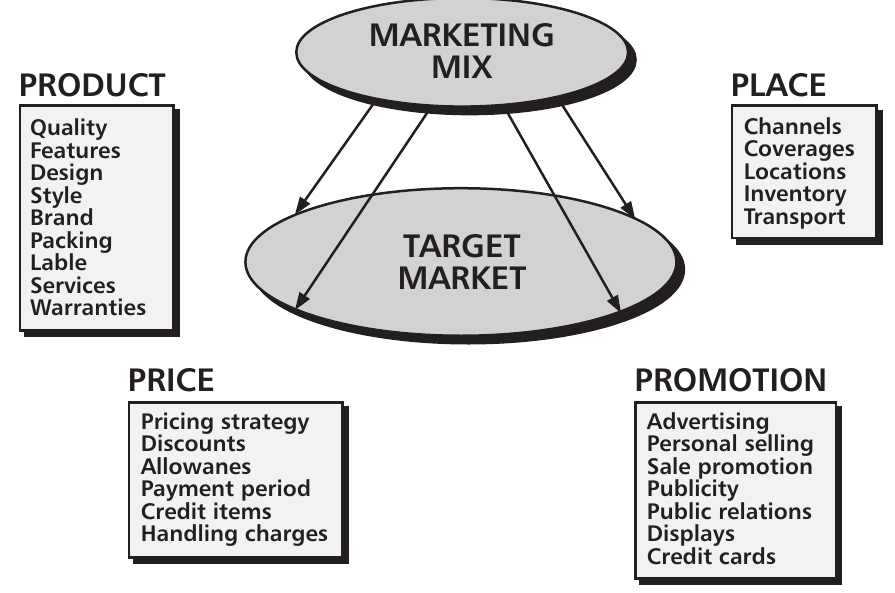
FIGURE 1. 4Ps in marketing (adapted from Kotler et al.